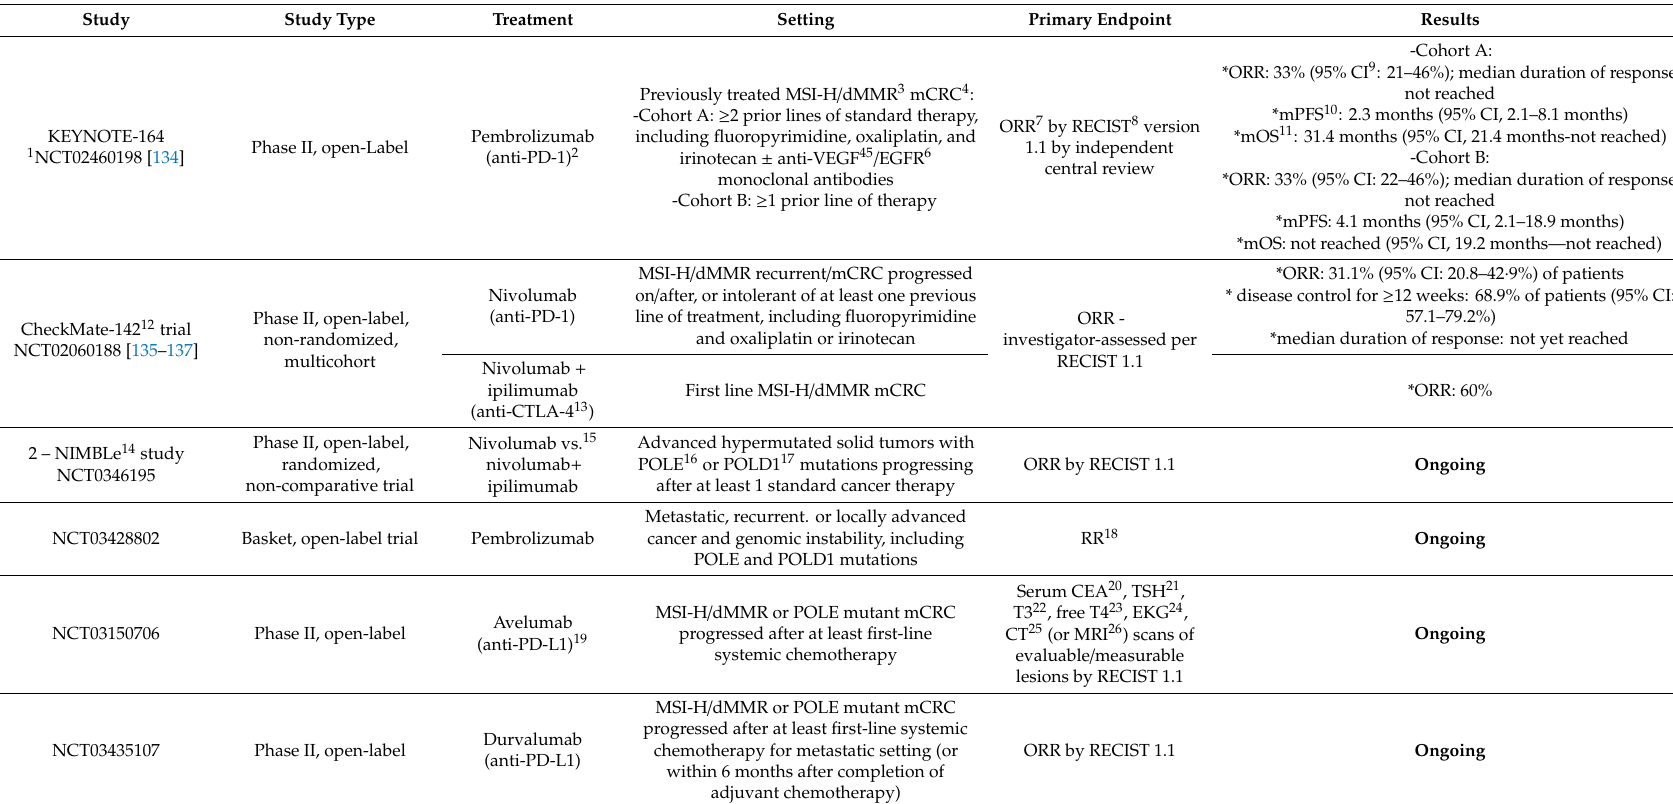
Table 6. Immunotherapy trials involving metastatic colorectal cancer